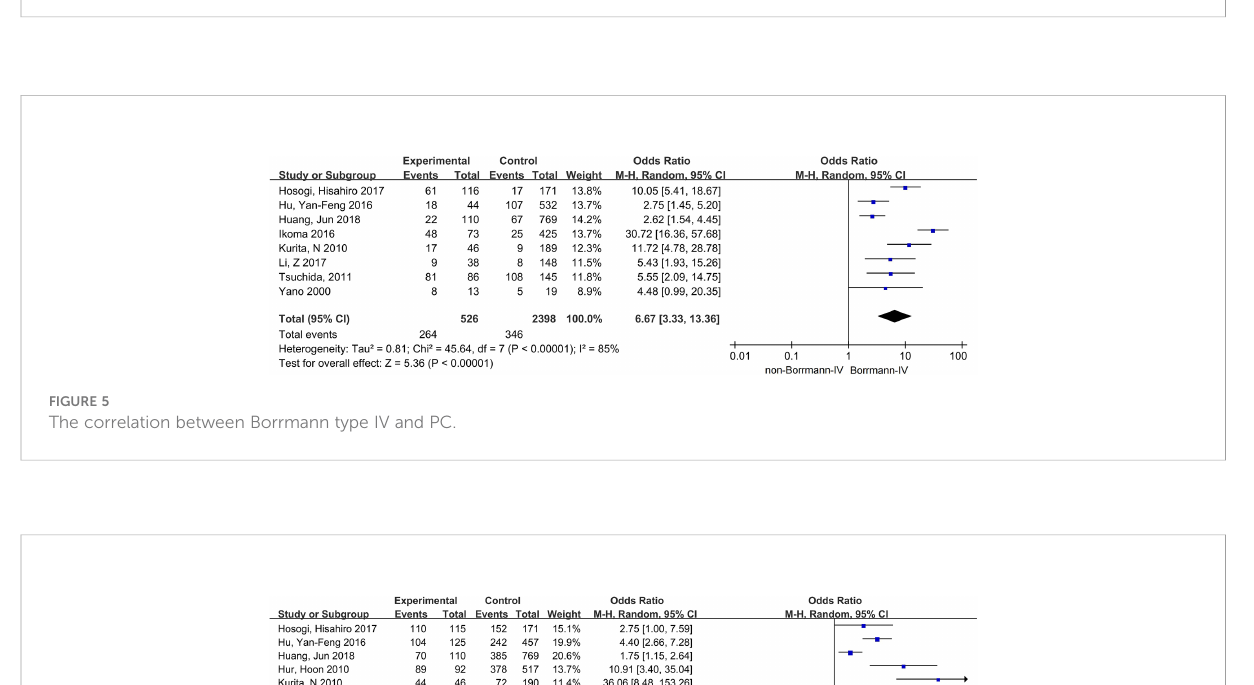
FIGURE 4 The correlation between differentiation degrees and PC.